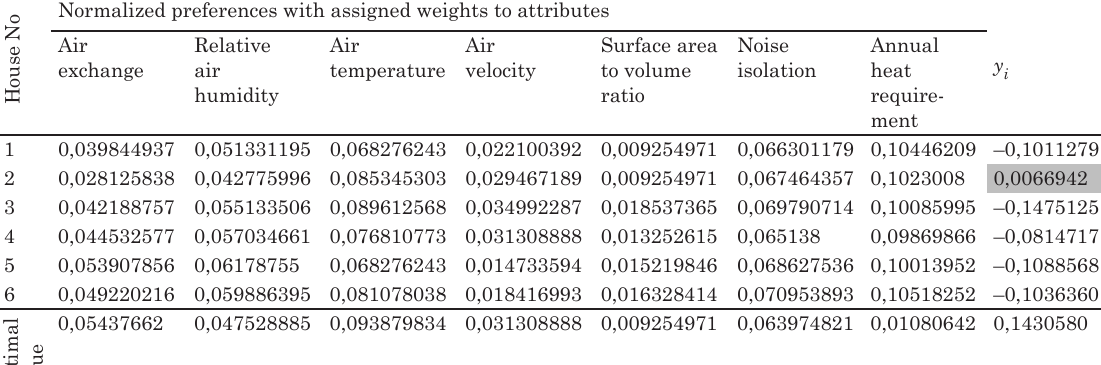
Table 5. Normalized preferences with assigned weights to attributes to the 6 apartments in Naujoji Vilnia, Vilnius Normalized preferences with assigned weights to attributes